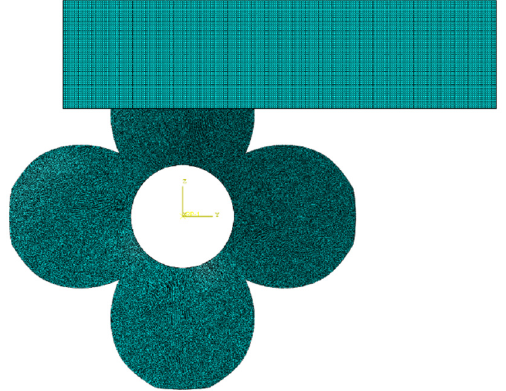
Figure 6. The relative position of the ice and the propeller.